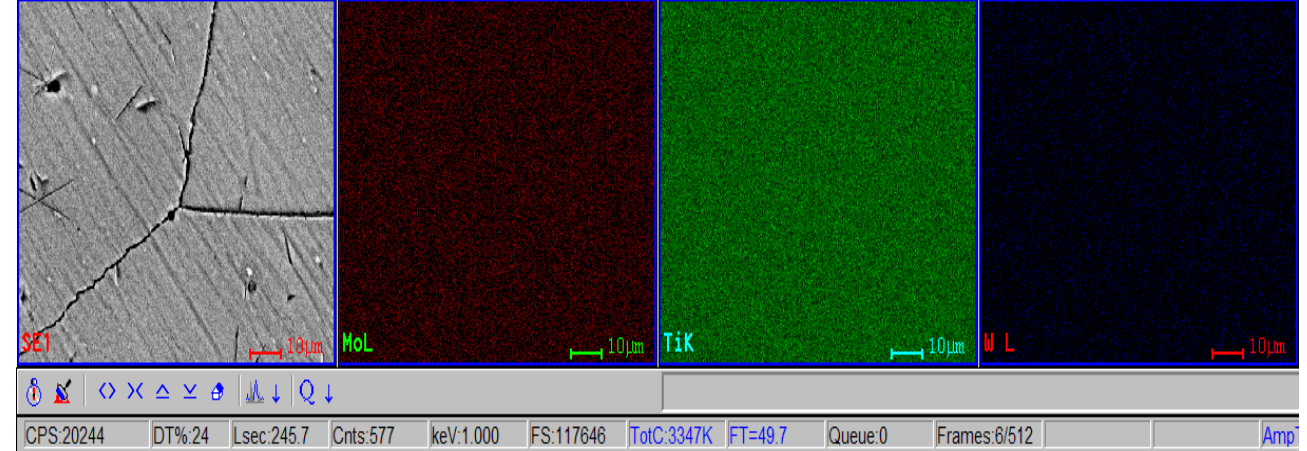
Figure 9. SEI image and BSED mapping of the Ti19Mo10W sample (Code 4) showing the repartition of W, Mo, and Ti.